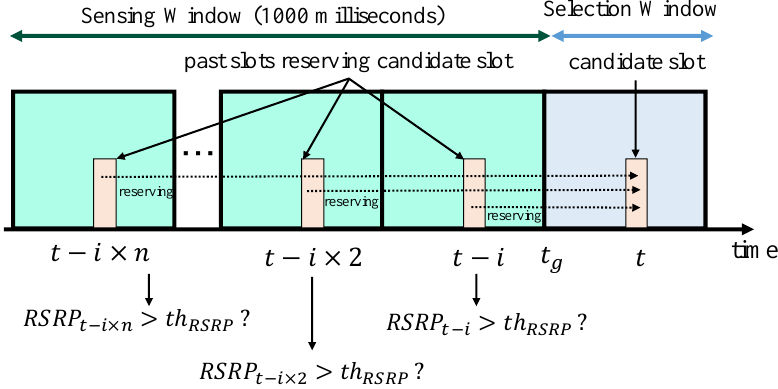
Figure 3. The abstract image of the RSRP mechanisms at time 𝑡 𝑔 .